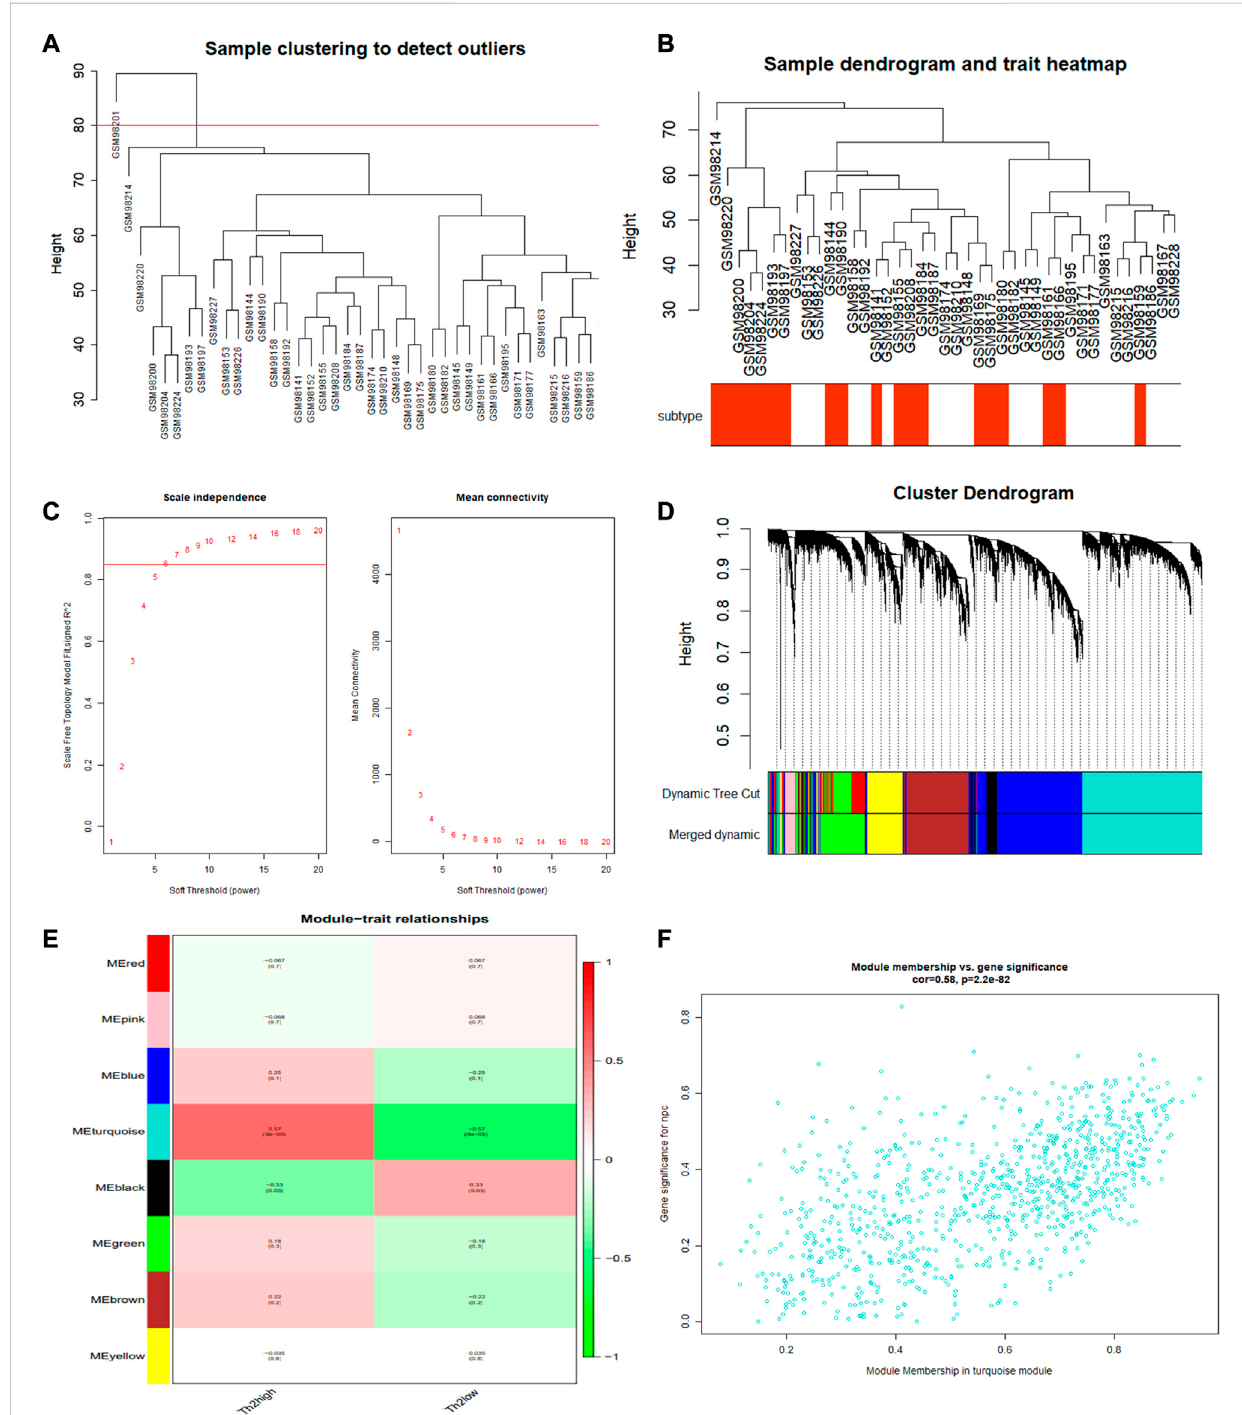
FIGURE 3 WGCNA performed for identifying gene modules signi fi cantly related to T2-low asthma. (A) Sample clustering; (B) Heat map of sample clustering and its characteristics; (C) Filtering of soft thresholds; (D) Clustering dendrogram of differentially expressed genes; (E) Heatmap of the correlation between module and clinical traits (each cell contained the correlation coef fi cient and corresponding p -value); (F) The gene signi fi cance for T2-low asthma in the turquoise module (one dot represents one gene in the turquoise